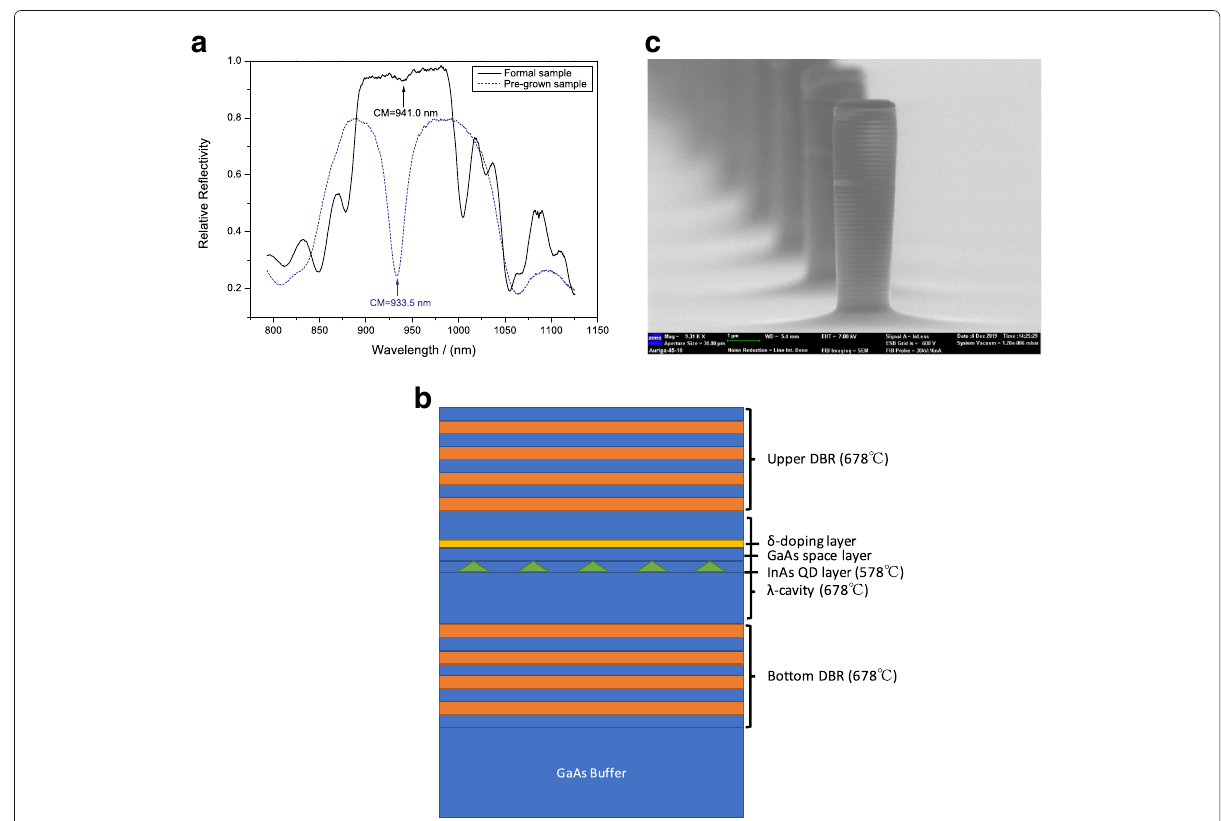
Fig. 1 a The reflection spectra at room temperature ( T = 300K) of the pre-grown sample with 6.5 pairs lower and 4 pairs upper DBR and the formal sample after the precise cavity mode calibration process with 25.5 pairs lower and 15 pairs upper DBR. b Schematic structures of the formal sample. c Scanning electron microscope (SEM) image of the micropillar cavity with diameter of 2.0 μ m and height of 6.5 μ